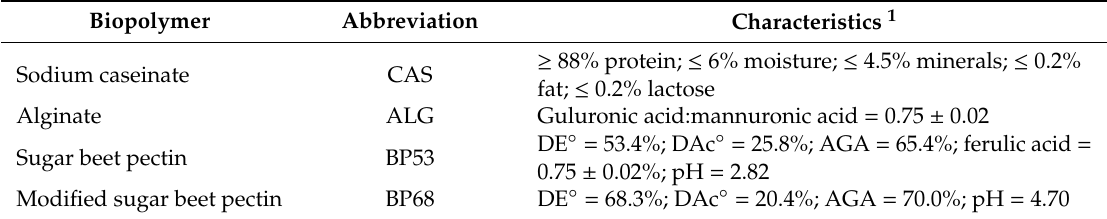
Physicochemical properties of the biopolymers used to investigate the segregative phase